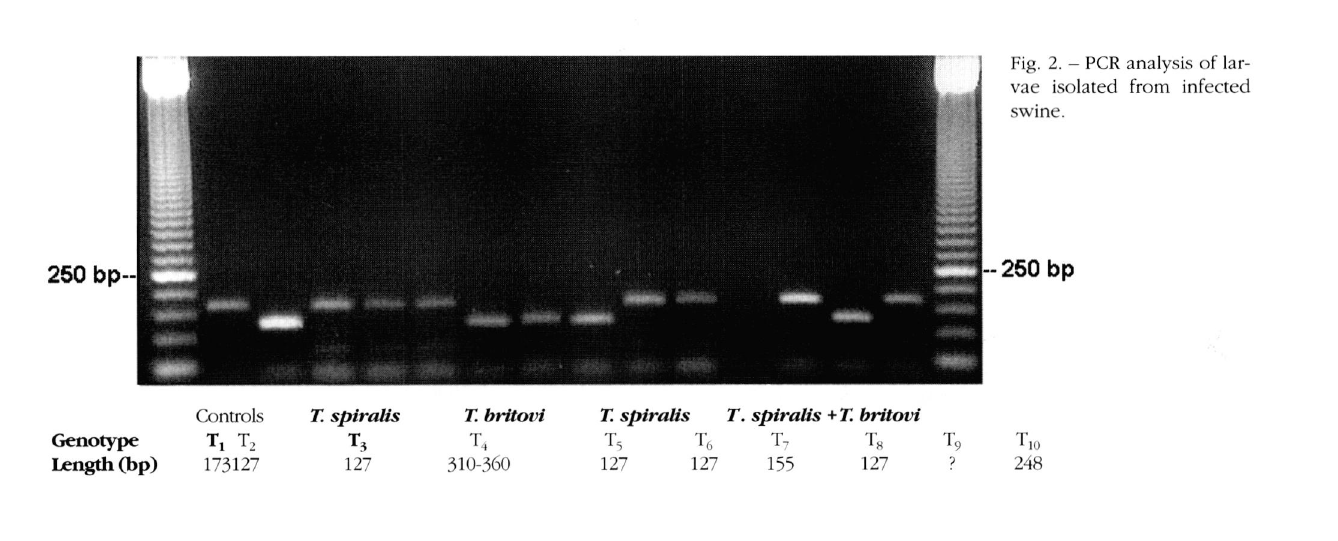
Fig. 2. - PCR analysis of lar vae isolated from infected